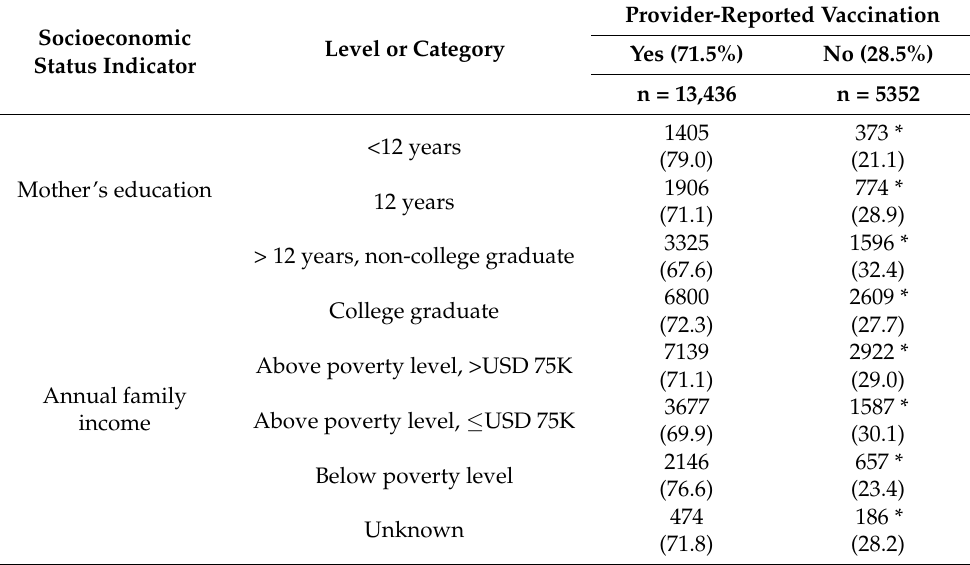
Table 5. The proportion of HPV-unvaccinated teens with the provider-reported vaccination record (Method 2: “No” vaccination) in Subsample A (N =